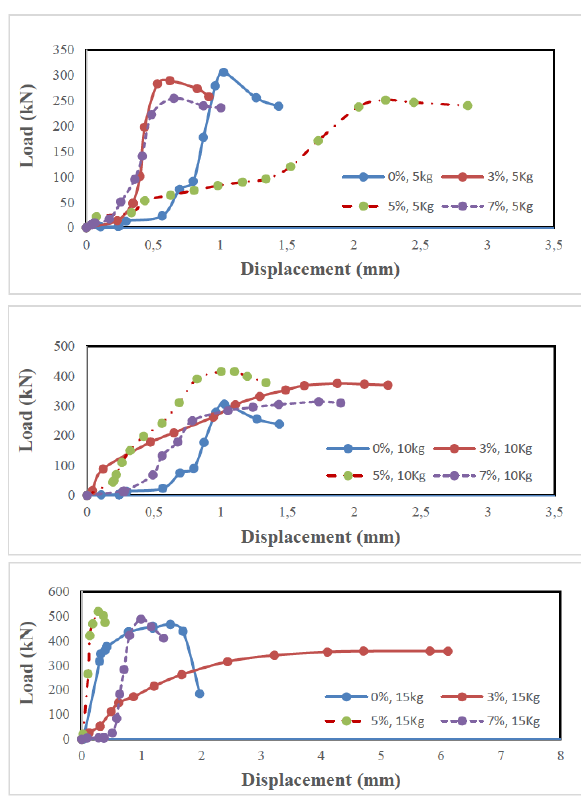
Figure 6: Relationship between falling water in a pipe for the con- soil (0%) at 3 days of